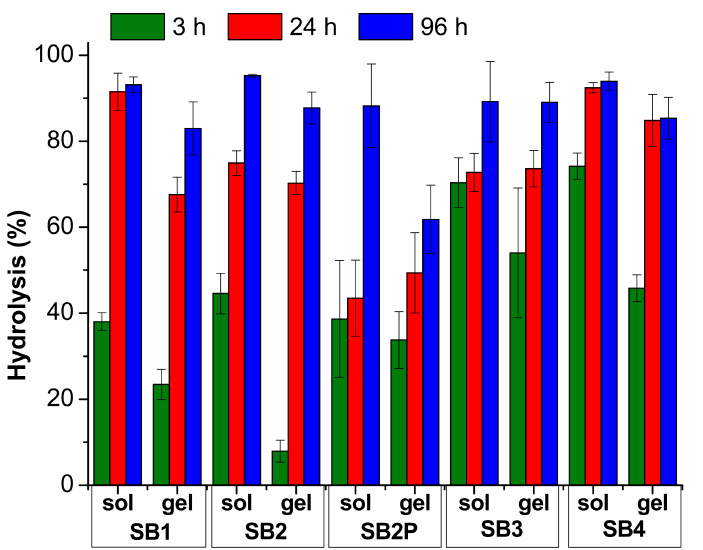
Figure 4. Hydrolysis results for the SB under neutral conditions. The data are reported as mean value and standard deviation.